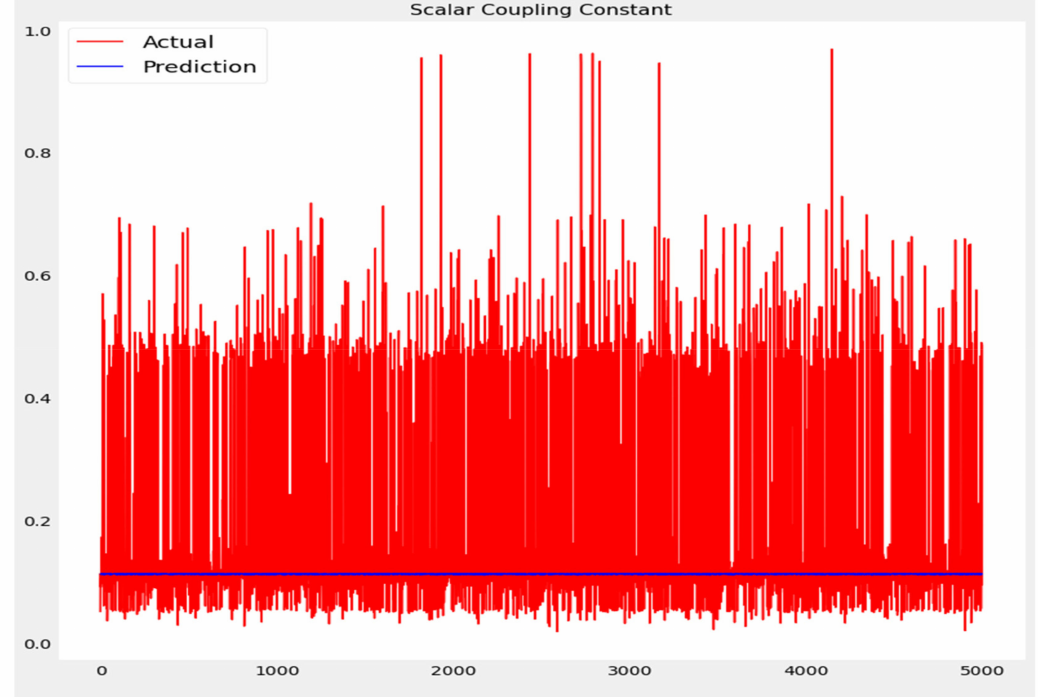
Figure 11. Actual and prediction values of